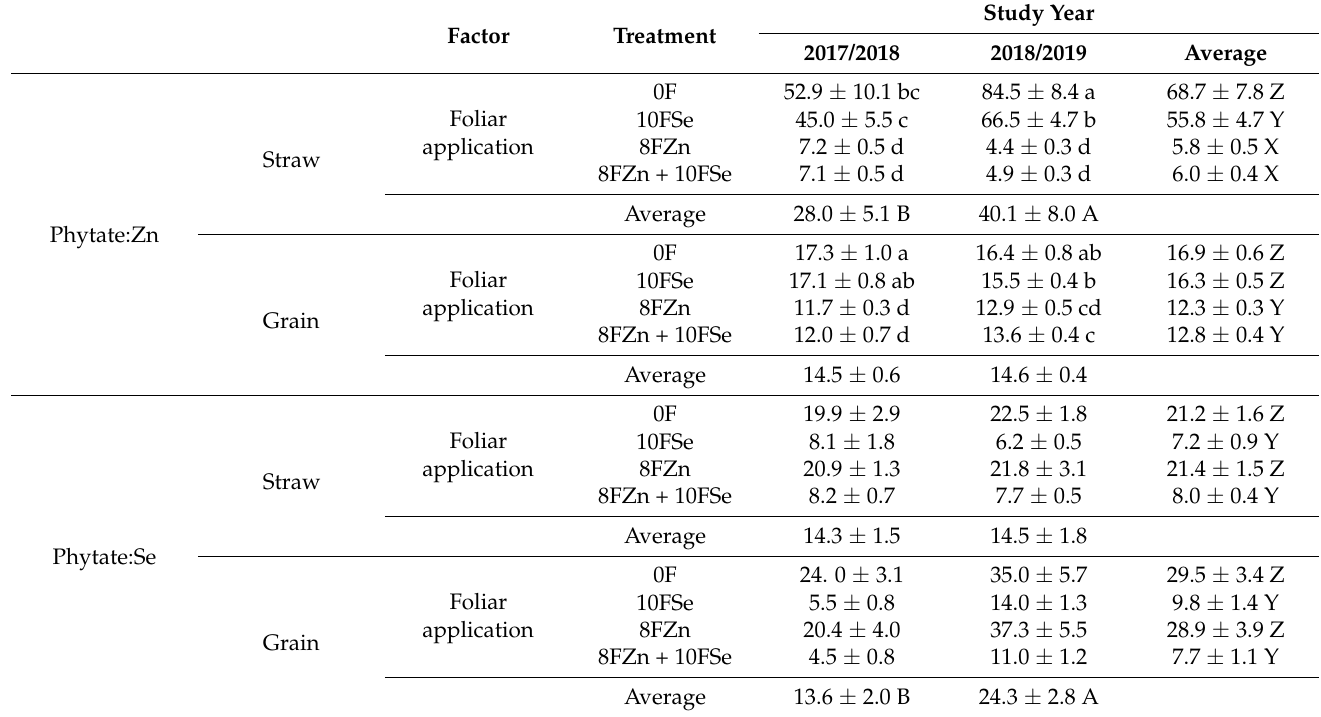
Within each parameter and factor, different letters mean significant differences between means according to LSD test ( p ≤ 0.05). If letters do not appear, this factor did not have a significant effect according to split-split-plot ANOVA. To make the differences clearer, a different set of letters was assigned to each factor (lowercase letters [a, b, c, d] for ‘Y*F’, uppercase letters [Z, Y, X] for ‘F’ and uppercase letters [A, B] for ‘Y’.